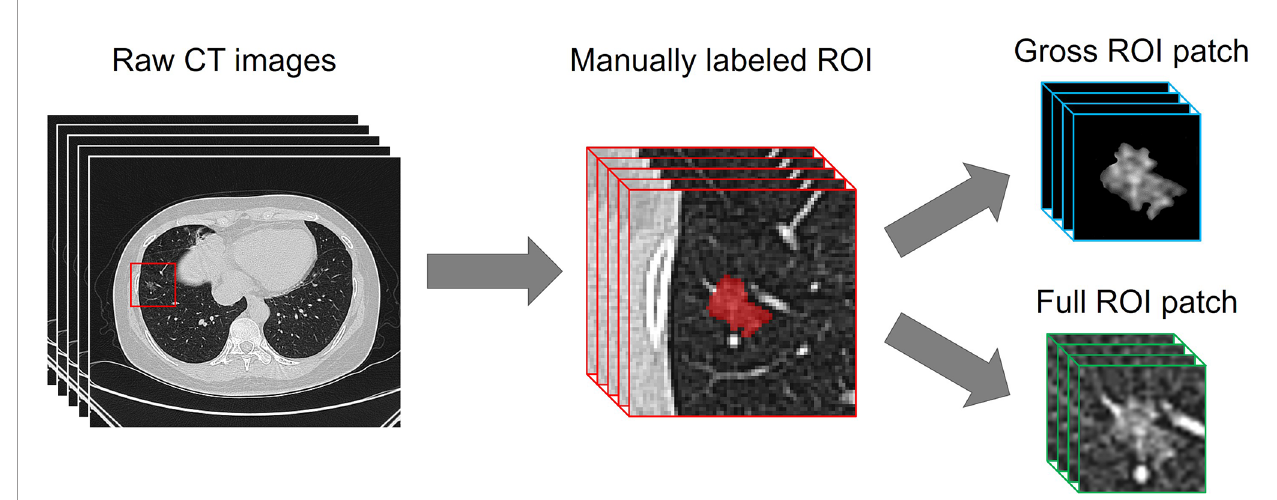
FIGURE 2 | Examples of the automatedly generated gross ROI patch and full ROI